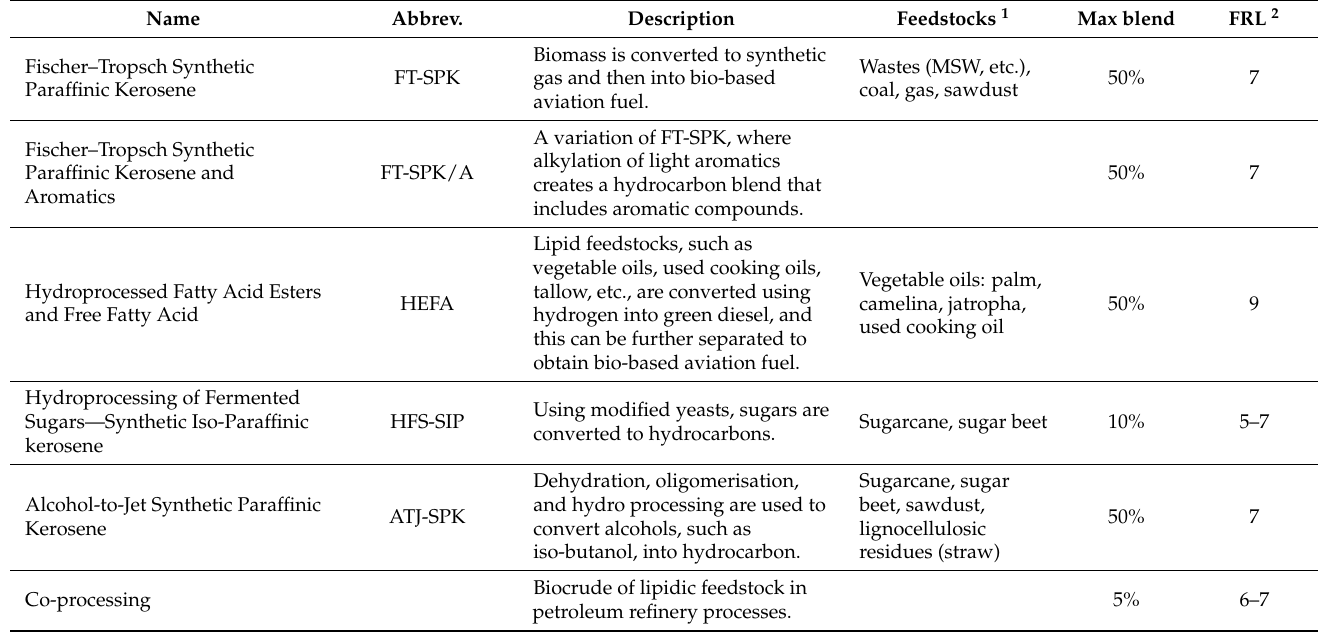
Table 1. Approved sustainable aviation fuels as per ASTM D5766